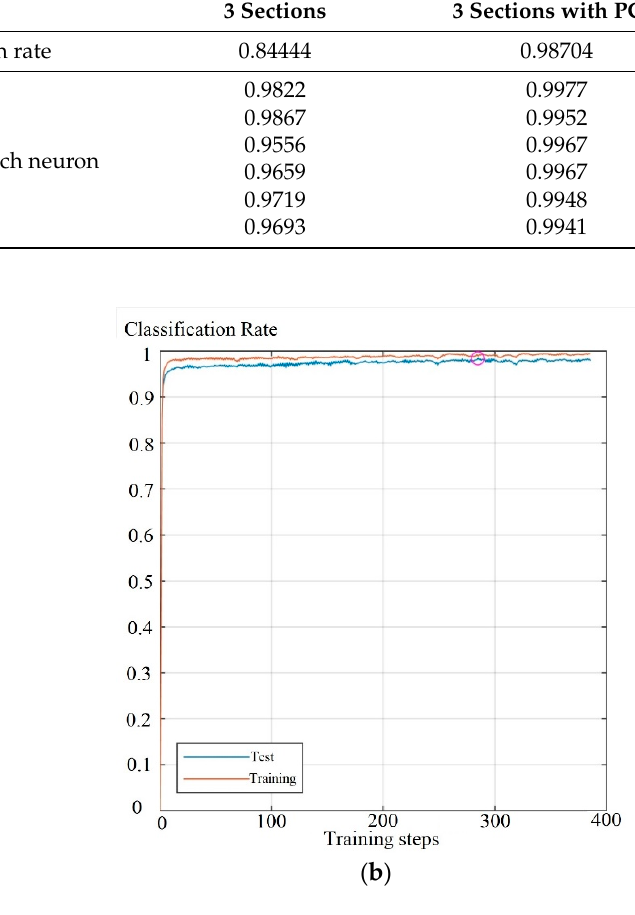
Figure 10. Classification results obtained for a network branch with four cable sections: ( a ) Global classification rate obtained during the test and training phase by using a dataset with four frequencies; ( b ) Global classification rate obtained during the test and training phase by applying the principal component analysis to a dataset with 100 frequencies.